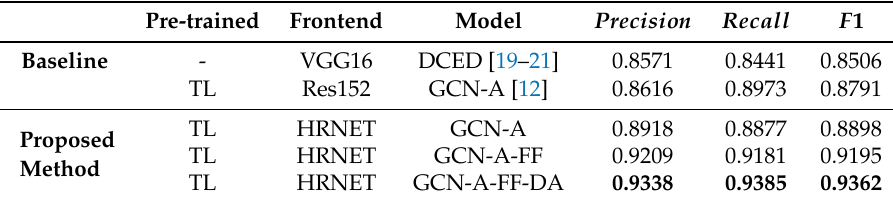
Table 5. Effects on the testing set of Landsat-8w5c data set.